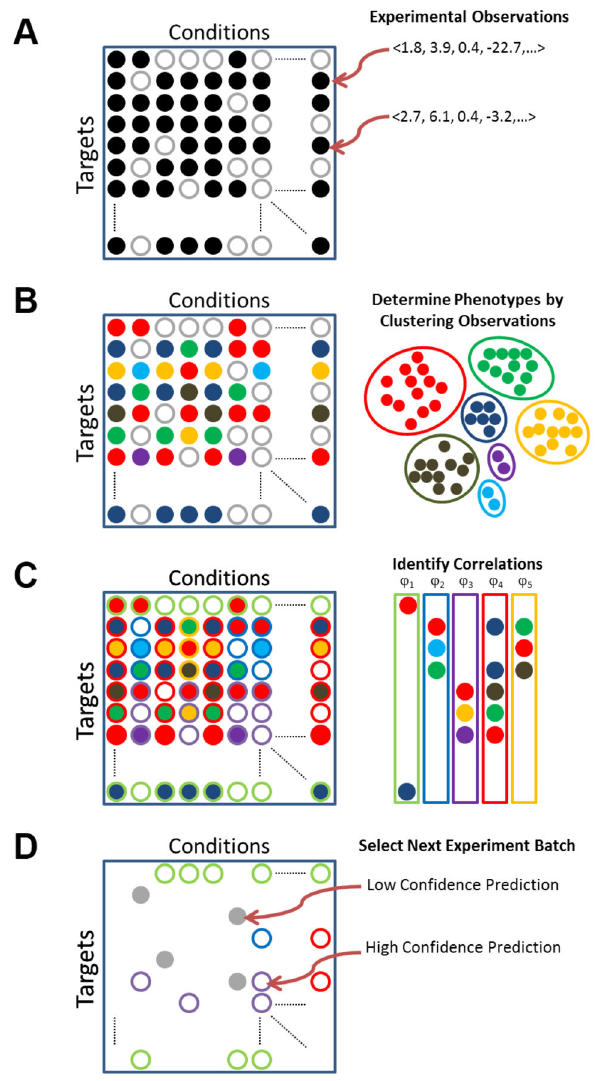
Figure 1. Active Learning Process. (A) An experiment is a combination of a target and a condition; observed experiments (filled circles) associate a target and condition with a vector encoding an experiment result. (B) Phenotypes (filled colored circles) are identified by cluster analysis of the experiment results. (C) From the arrangement of phenotypes across targets and conditions, a small set of correlations ϕ (distributions of phenotypes across targets) are identified which are then used to impute unobserved experiments. (D) A batch of experiments (filled grey circles) is selected based in part on predictions (outlined colored circles) from the identified correlations. The process (B-D) is repeated until a desired goal is